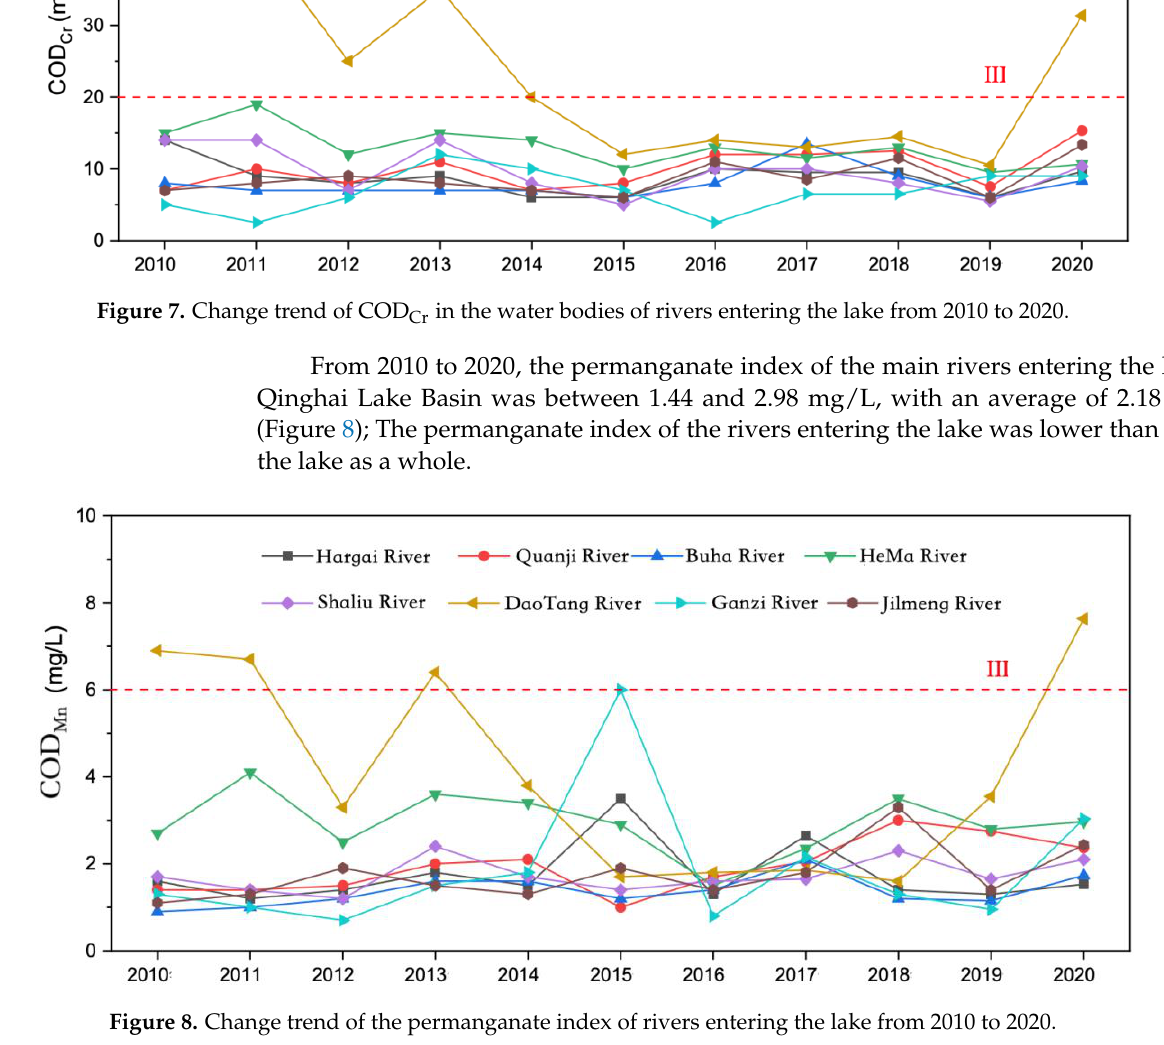
Figure 7. Change trend of COD Cr in the water bodies of rivers entering the lake from 2010 to 2020.